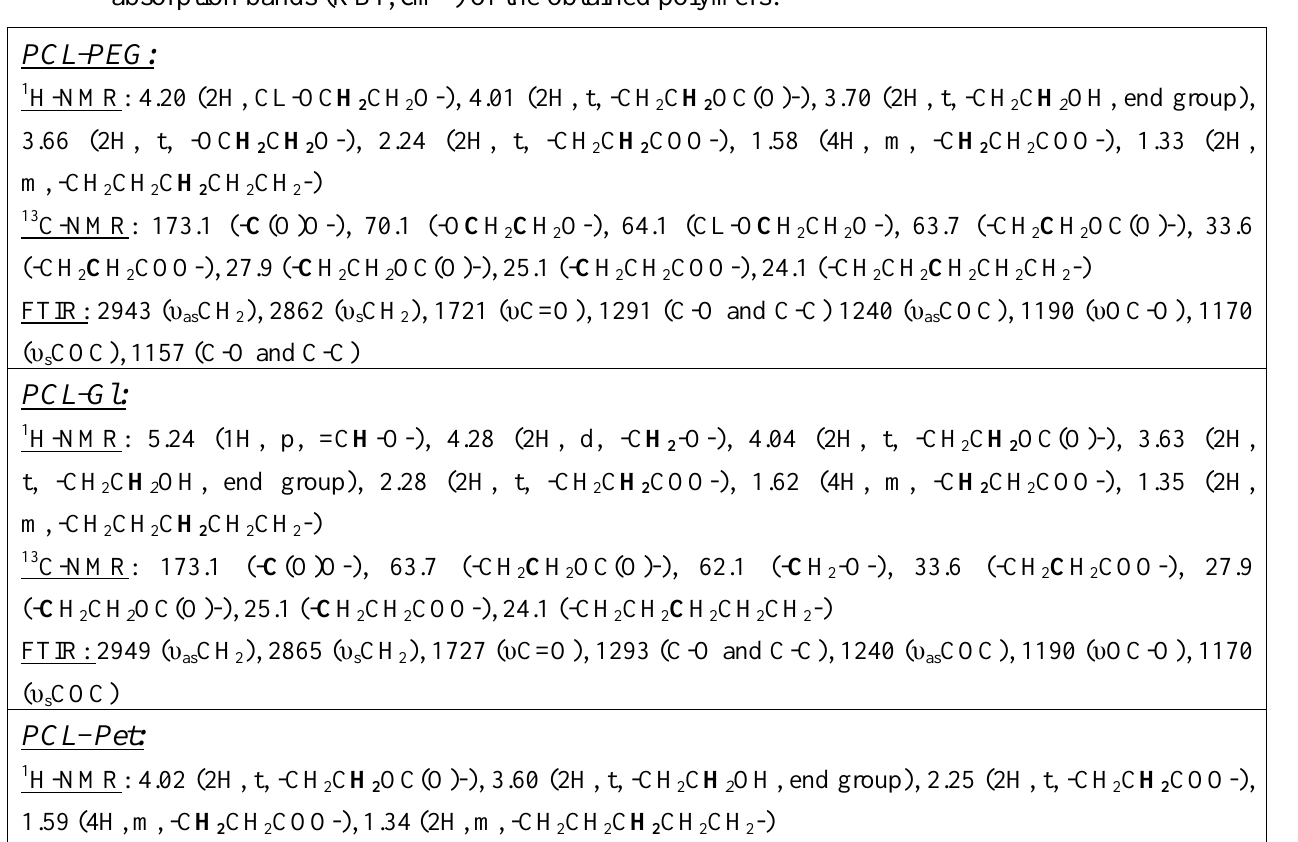
Table 2. 1 H- and 13 C-NMR (CDCl absorption bands (KBr, cm -1 ) of the obtained